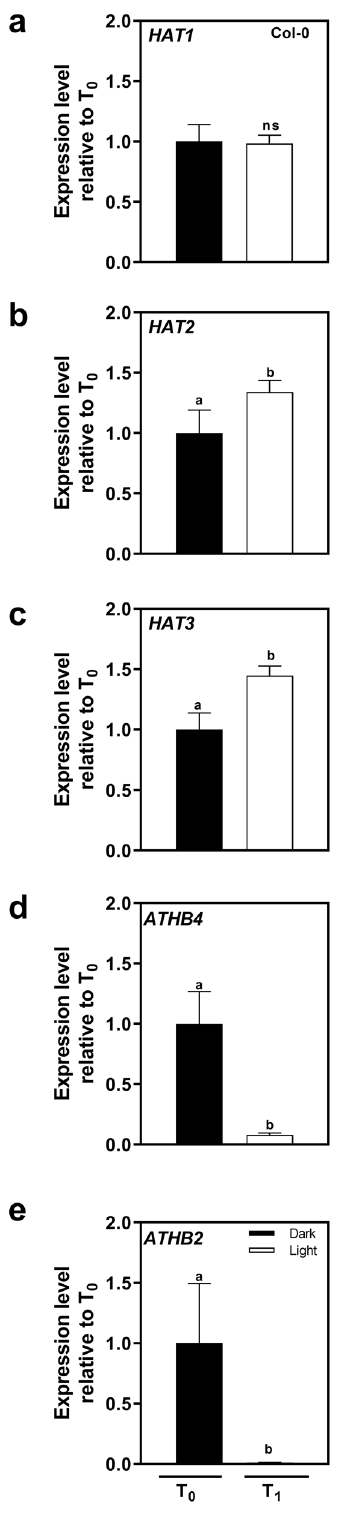
Figure 2. Continuous white light regulates the gene expression of HD-ZIP II members in Col-0 seeds. Seeds were sown for 2 h in darkness (D) and then irradiated with a FRp. Seeds were then incubated for 72 h at 5 °C in D and then incubated at 22 °C under continuous white light (WLc). RNA was extracted from imbibed Col-0 seeds stratified for 3 days at 5 °C and then exposed to WLc for 12 h (defined as T 1 ) or kept in darkness prior to the irradiation (defined as T 0 ). Gene expression levels of ( a ) HAT1 , ( b ) HAT2 , ( c ) HAT3 , ( d ) ATHB4 and ( e ) ATHB2 were normalized to T 0 . Each bar represents mean ± ES (n = 3). Significant differences between means are shown with different letters ( p < 0.05 by ANOVA followed by Fisher post